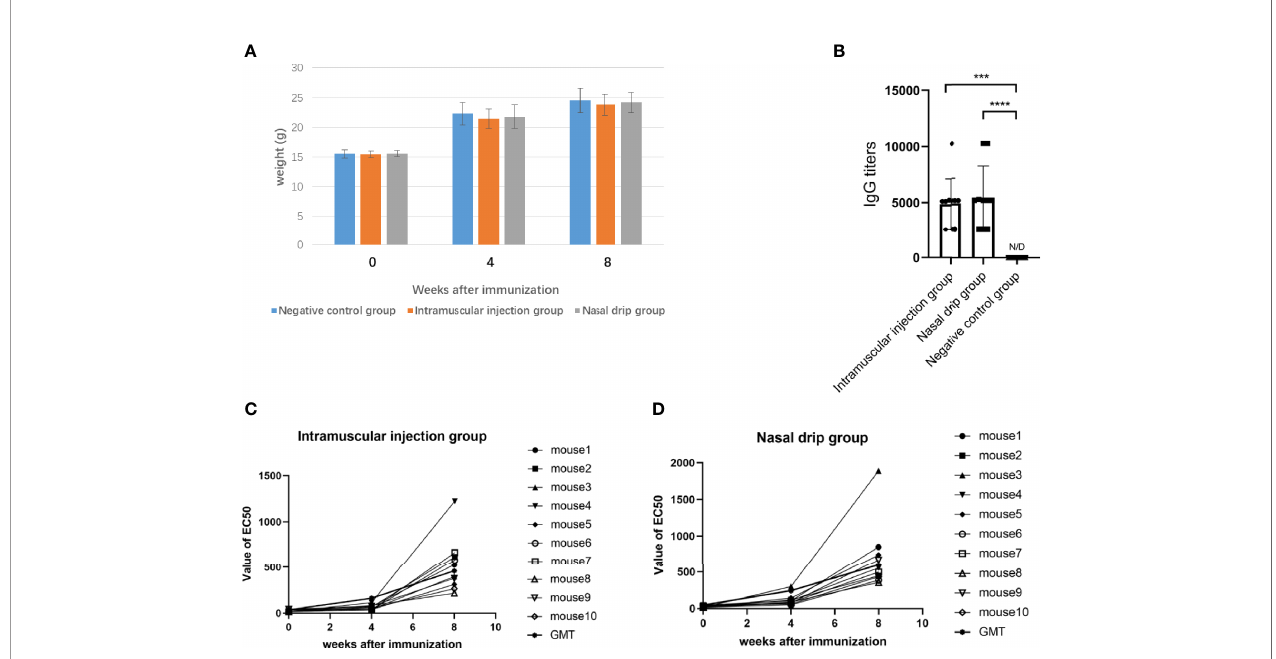
FIGURE 5 | The mice were immunized with recombinant AAV9-RBD via intramuscular injection and nasal drip administration. Weight changes of mice before and after immunization (A) . RBD-speci fi c antibody responses in sera of immunized mice 8 weeks after immunization. Endpoint titers of IgG determined by ELISA. The reciprocals of titers were represented as the mean ± SD. n = 10. ***p ＜ 0.0003; ****p ＜ 0.0001 (B) . The levels of the neutralizing antibody in each mouse group were determined before immunization, and 4 and 8 weeks after immunization via intramuscular injection (C) and intranasal administration (D)